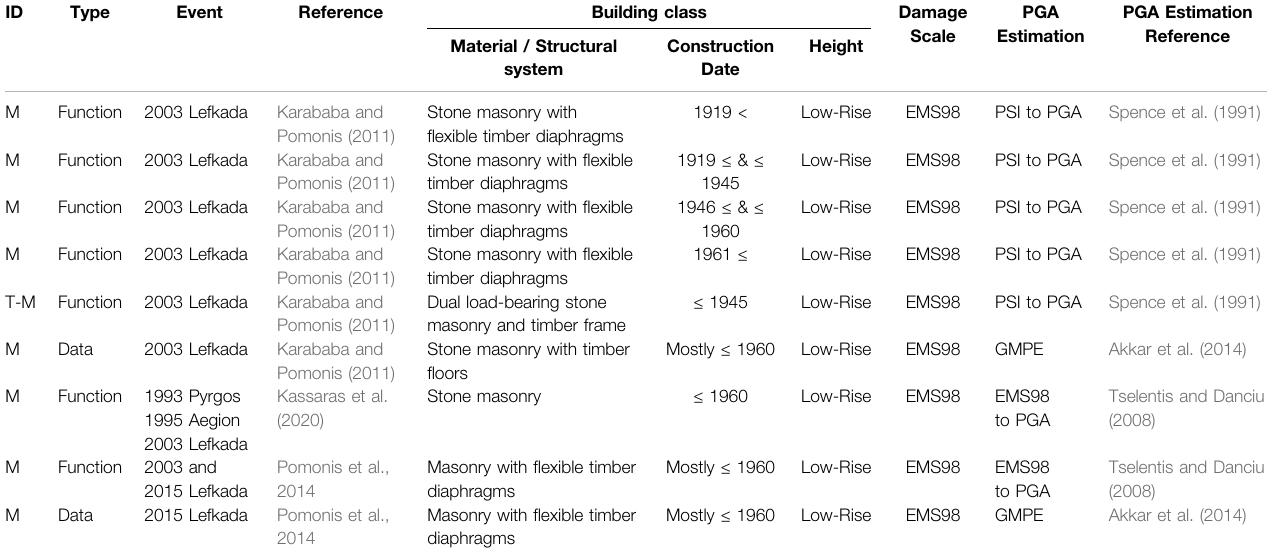
TABLE 4 | Key characteristics of the existing fragility curves used in this